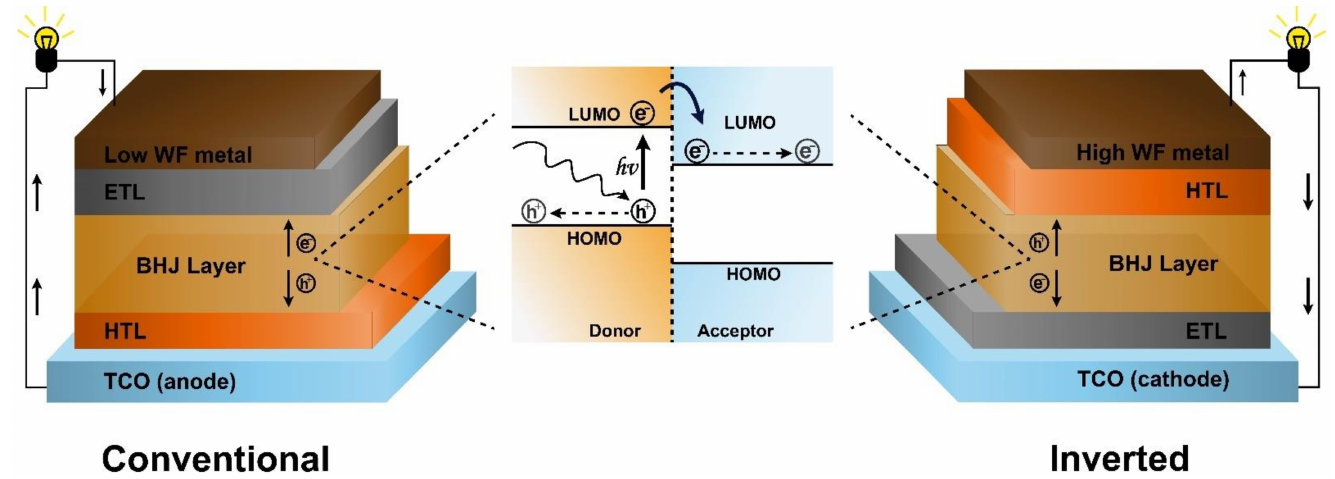
Figure 1. Schematic structure of conventional and inverted OSCs, and a simplified view of the operating principle in the active